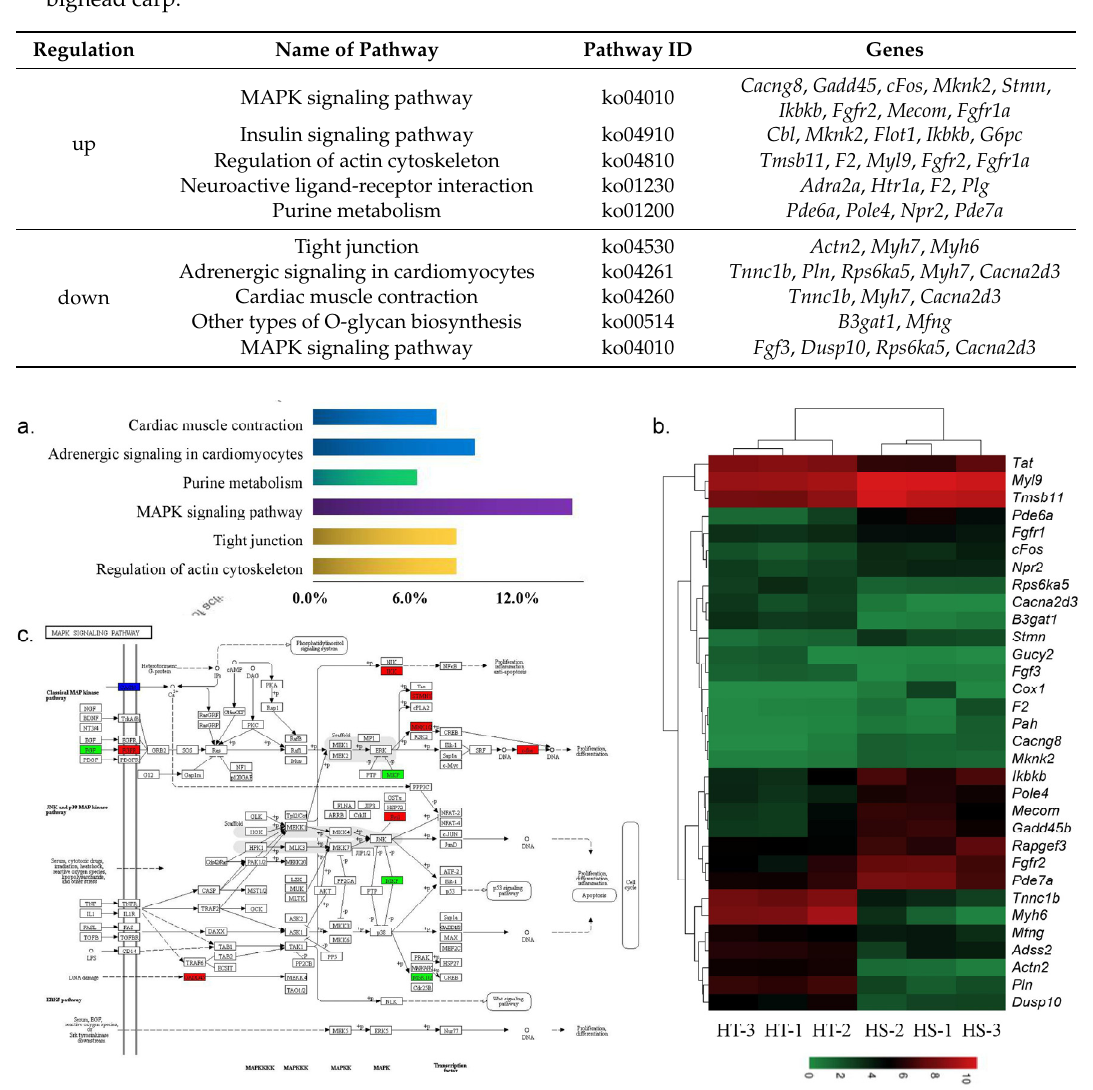
Figure 5. Patterns of selected DEGs between HS and HT groups: ( a ) main KEGG pathways classified by the DEGs in HS vs. HT; ( b ) heat-map of selected significant genes from main pathways; ( c ) annotation diagram of MAPK signaling pathway and its related